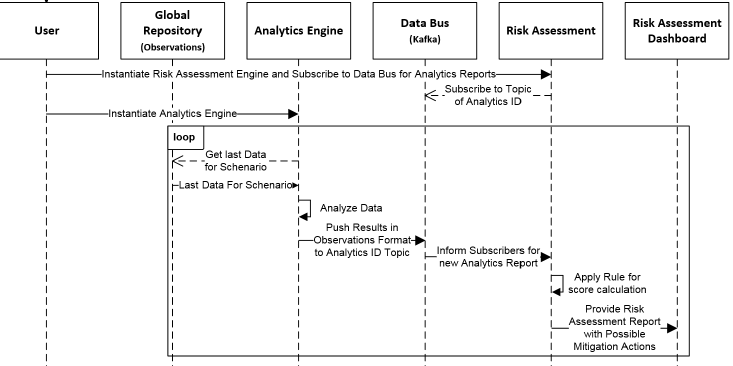
Figure 3. Data Management/Analytics/Risk Assessment Validation High Level Sequence